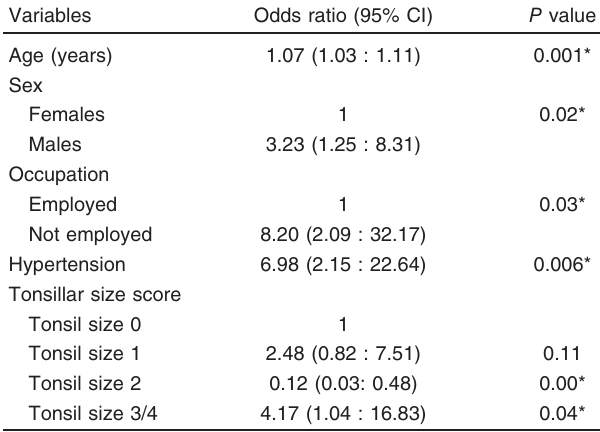
Table 5 Final model of predictive factors for obstructive sleep apnea